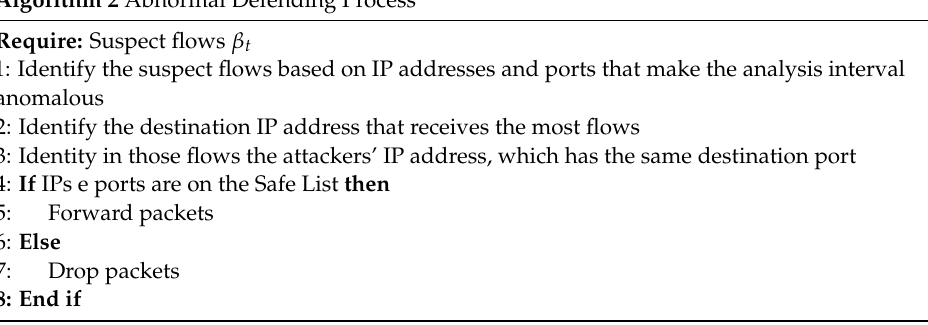
Algorithm 2 Abnormal Defending